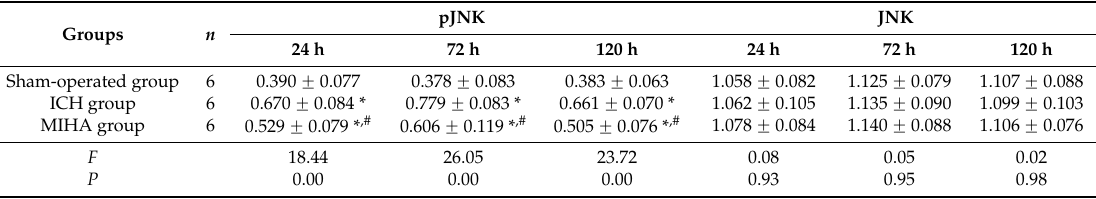
Table 5. The relative value of the proteins (RVPs) of pJNK and c-Jun NH 2 -terminal kinase (JNK) at each time point determined by Western blotting ( x ± s).